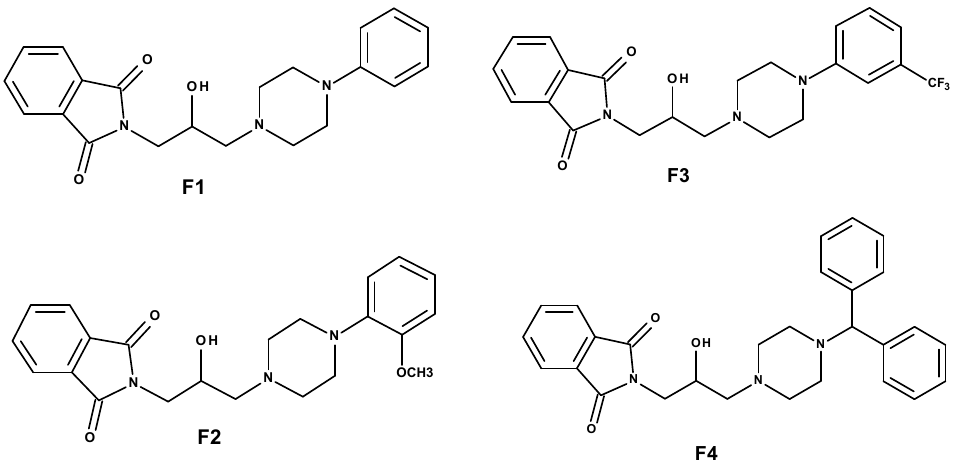
Figure 1. The structures of analyzed compounds F1, F2, F3, and F4.